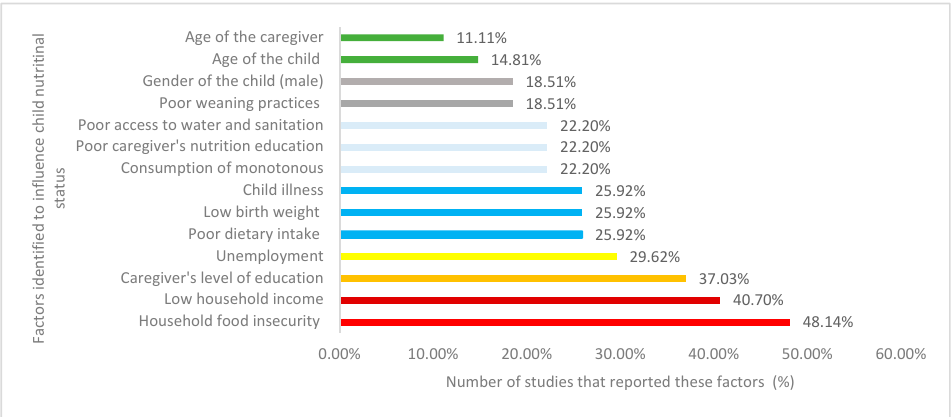
Figure 6. Factors influencing the nutritional status of children under five years of age in South Africa reported by the selected studies.